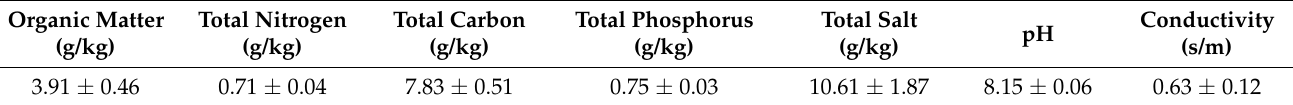
Table 1. Basic soil properties of Badain Jaran